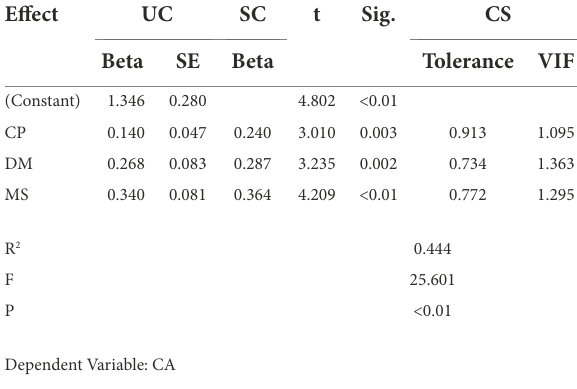
TABLE 4 Testing the effects of the predictors in the model on Cultural